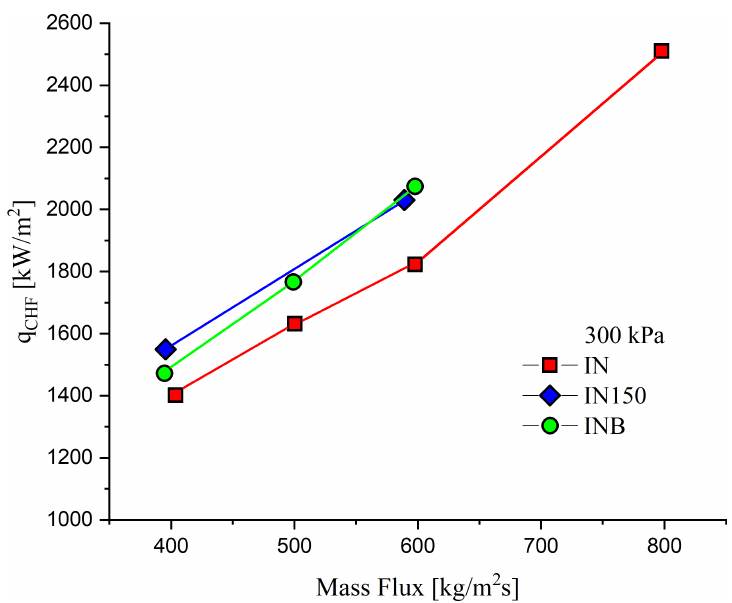
Figure 17. Measured CHF at p out = 300 kPa and T in = 91 °C on three different surfaces in the function of mass